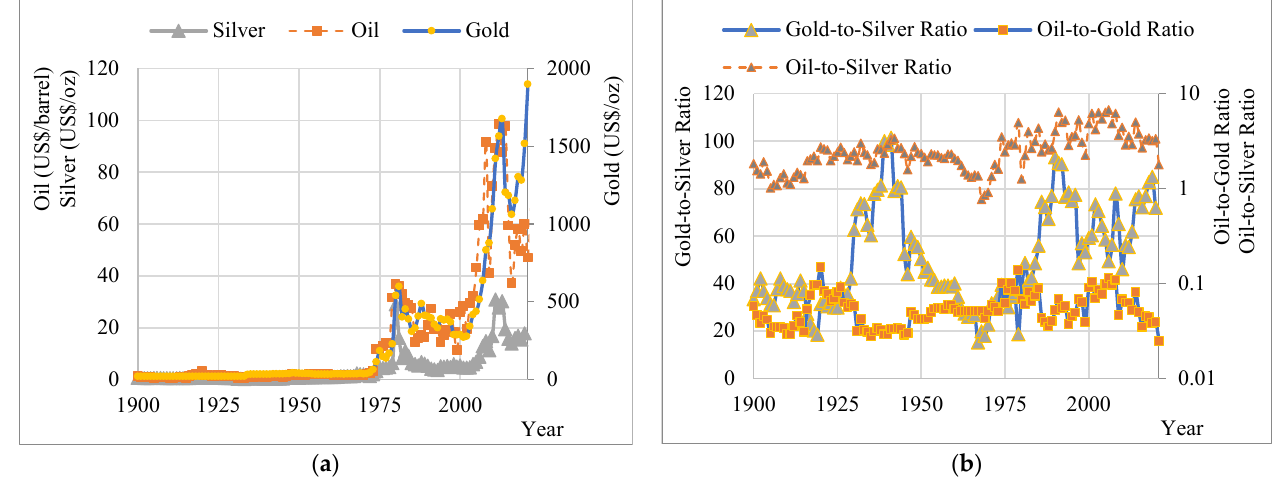
Figure 6. ( a ) Values of gold, silver and oil; ( b ) ratios of gold, silver and oil [35].